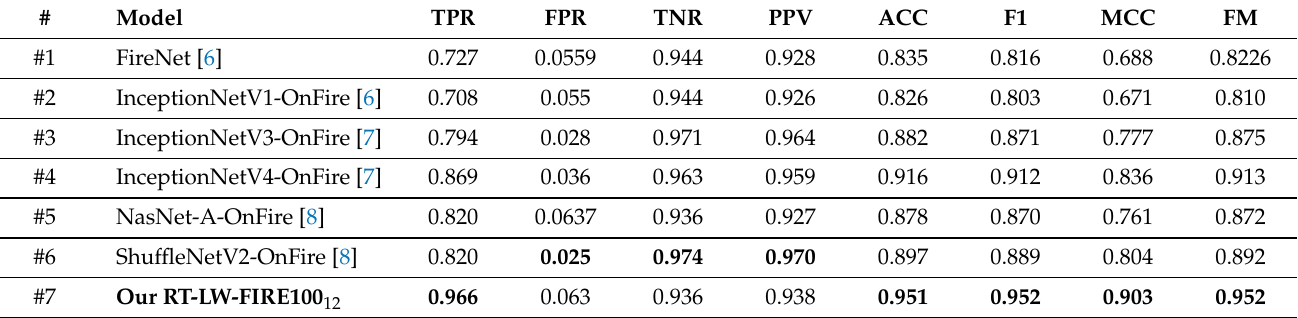
Table 7. Comparison with the state of the art on the dataset presented in this paper ( N = 12).